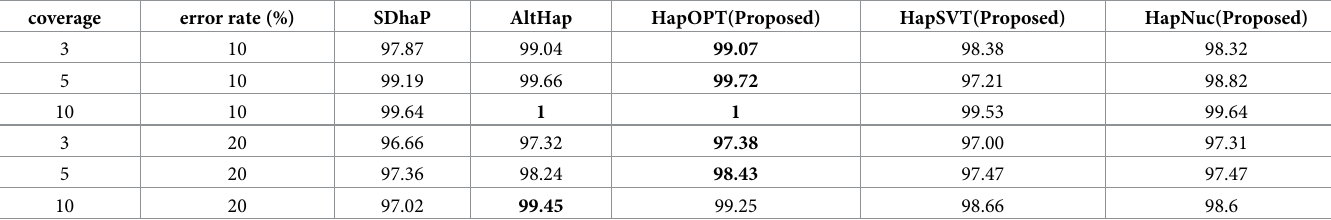
Table 3. Reconstruction rates for different algorithms on simulated data [21]. The best values are in boldface. coverage error rate